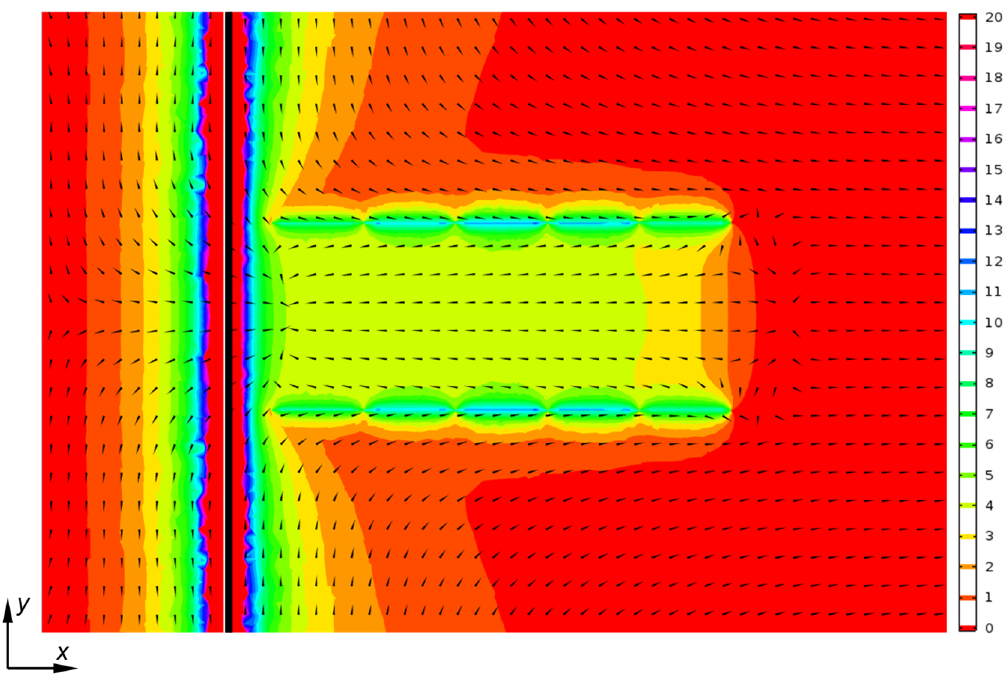
Figure 9. Magnetic field norm (color) and normalized power flow (black arrows) for the best model with the magnetic meta-hose ( ν = 0.15, µ m = 124) at f r = 100 kHz.